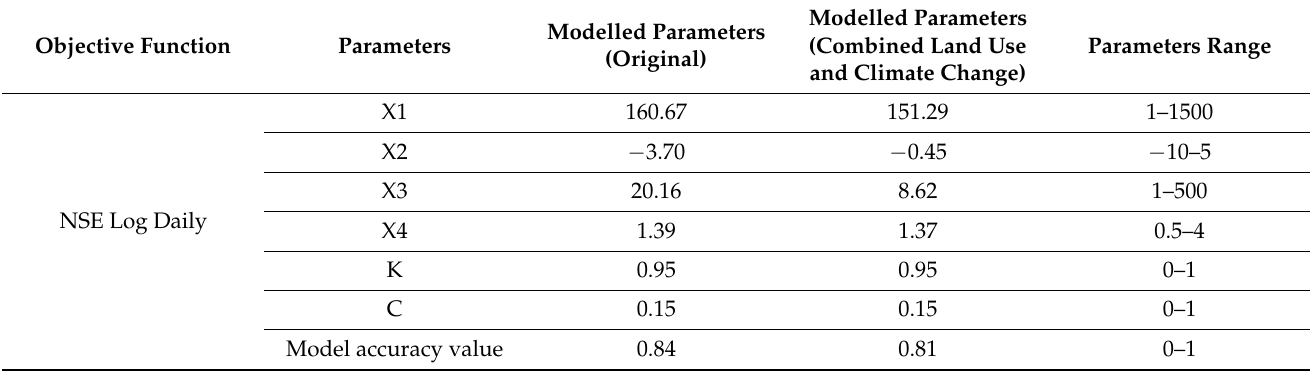
Table 12. The parameters of the rainfall–runoff models before and after combined land use and climate